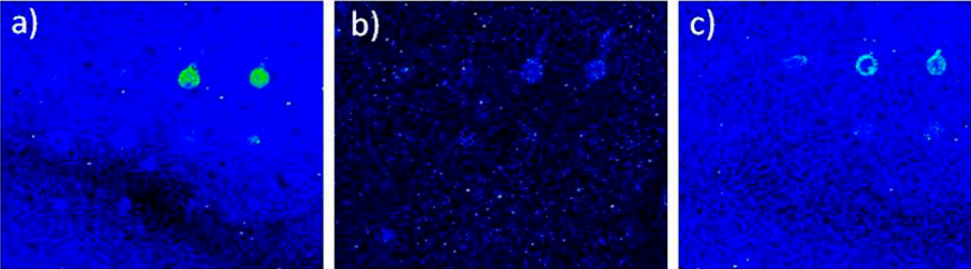
Figure 2. Protein chip detection of bacteria immunoseparated using in-house made magnetic beads. Fluorescence intensity showing the protein chip results of bacteria immunoseparated using three types of magnetic beads: ( a ) beads made using anti- Salmonella antibody indirectly bound by biotinylated group to streptavidin magnetic beads; ( b ) anti-Gram negative antibody; ( c ) Pathatrix beads. Scale: square size 4 mm.